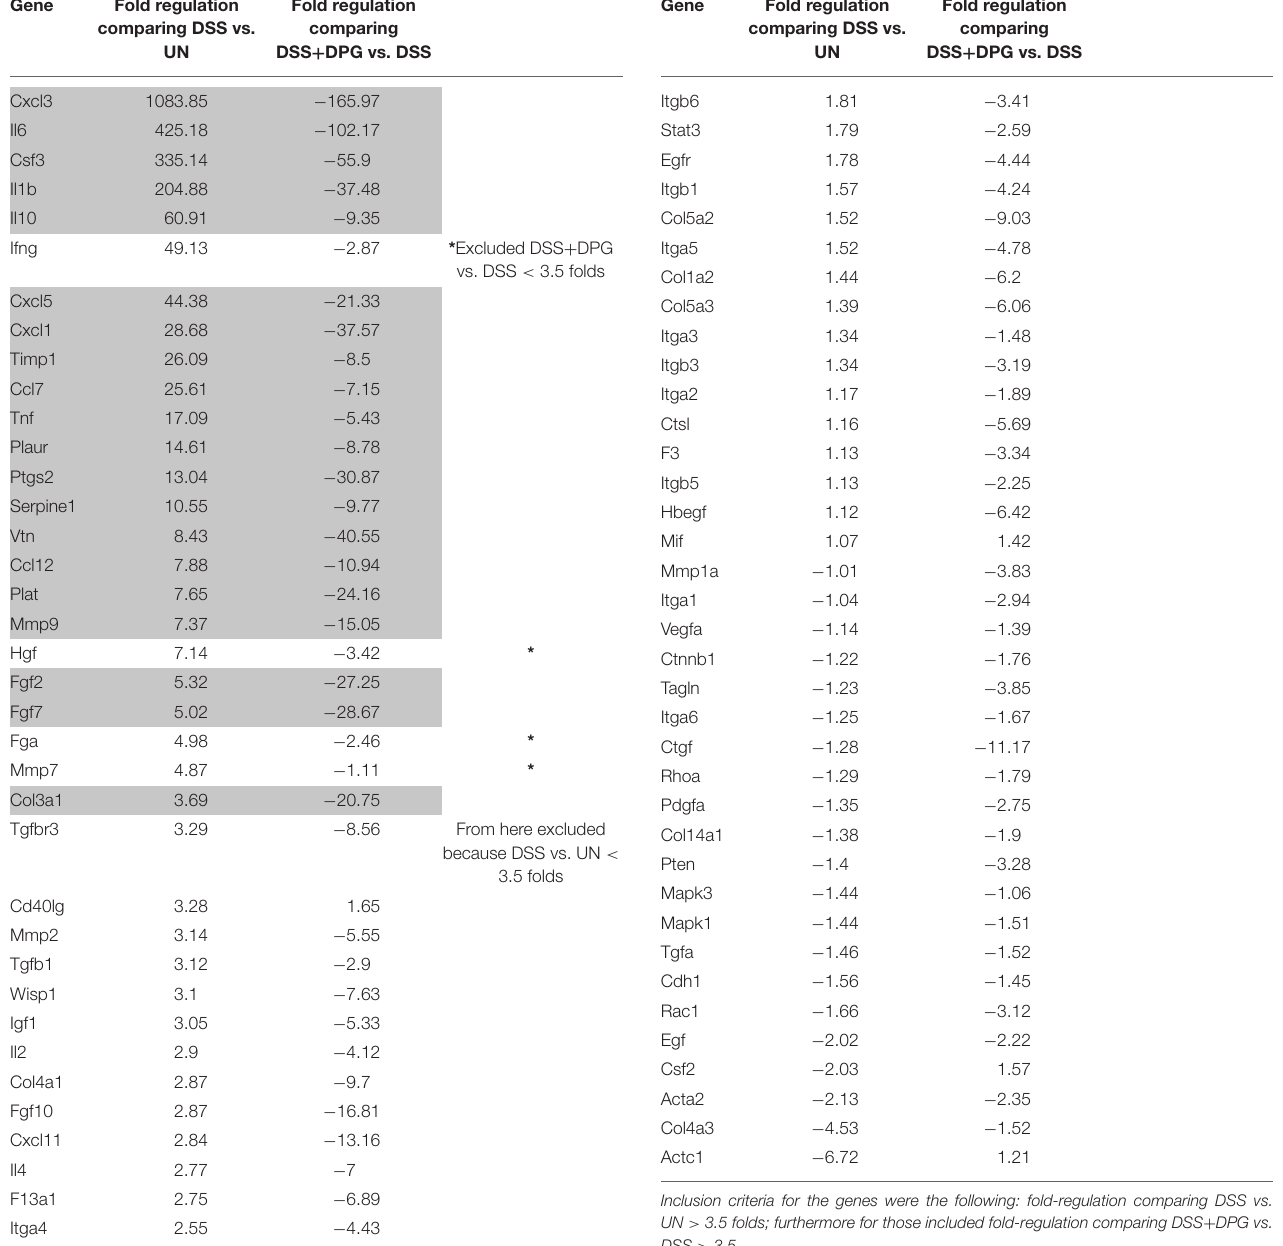
TABLE 2 | List of the mucosal healing pathway genes analyzed. Gene Fold regulation comparing DSS vs.